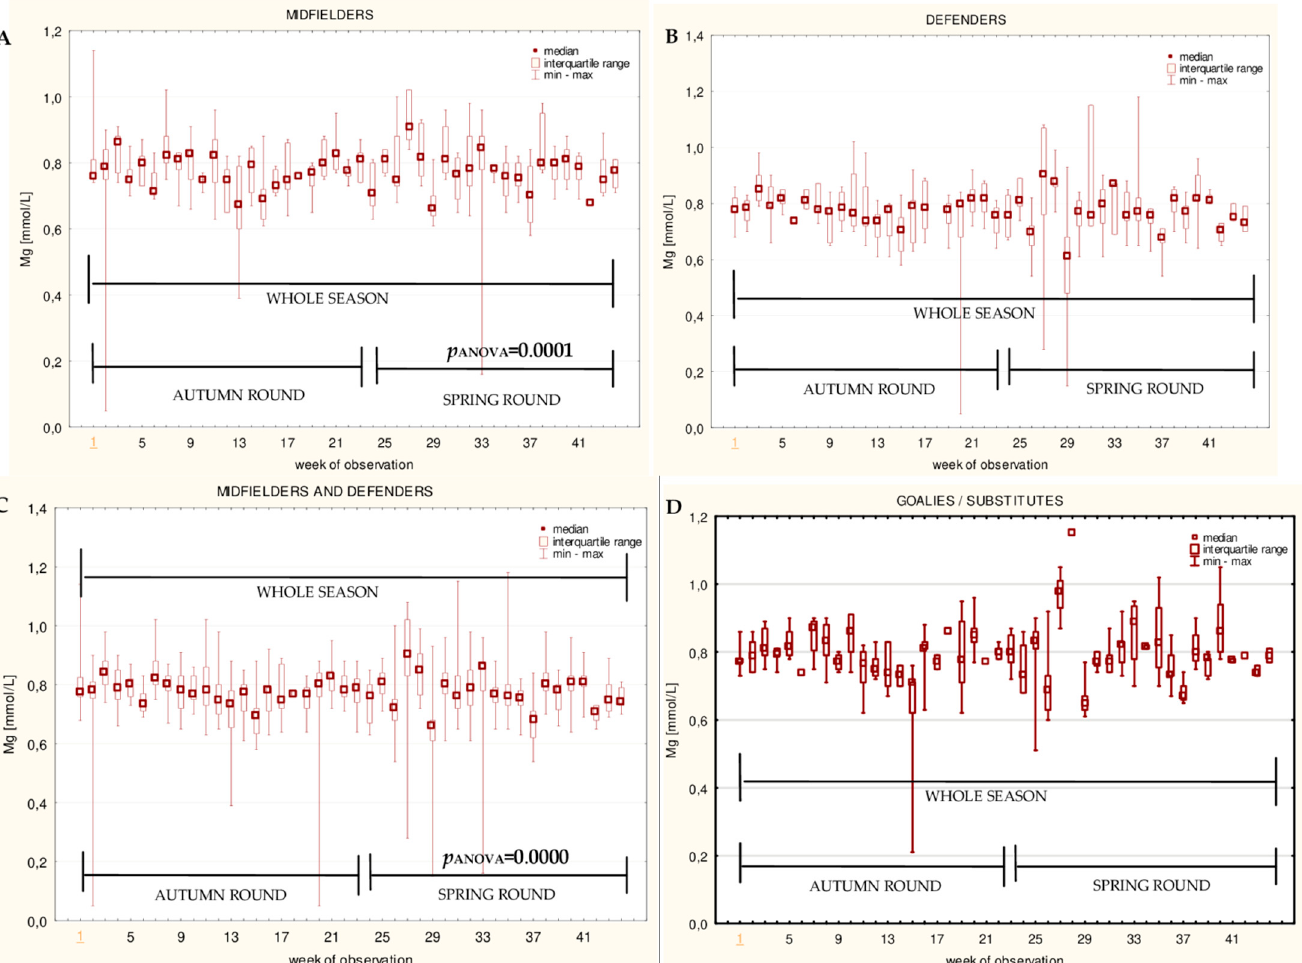
Figure 8. Median magnesium (Mg) levels in: ( A ) The midfielder, ( B ) defender, ( C ) midfielder / defender and ( D ) goalie / substitute subgroups over the course of the soccer match